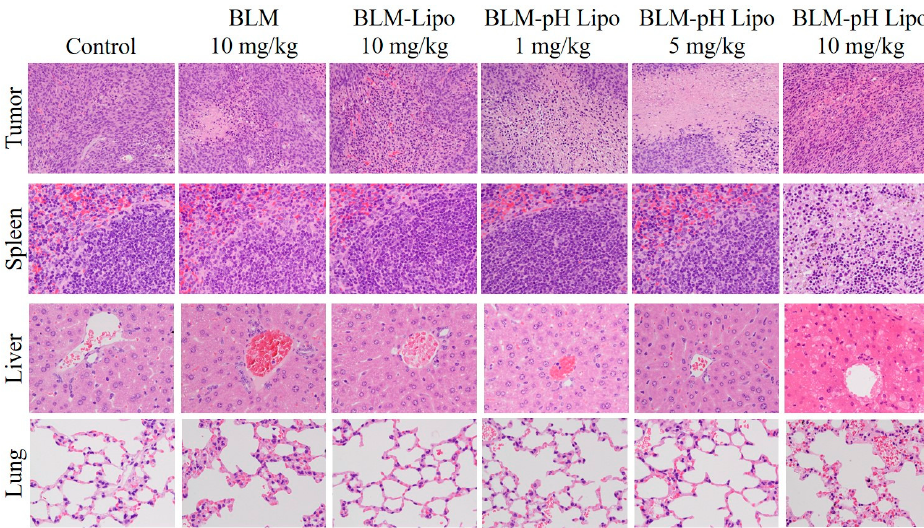
Figure 7. Evaluation of systemic toxicities by hematoxylin and eosin (H&E) staining showing histopathological changes in tumor, spleen, liver, and lung. In the cases of the control, BLM, BLM-Lipo (10 mg/kg), BLM-pHLipo (1 mg/kg) and BLM-pHLipo (5 mg/kg) groups, organs were isolated 12 days after treatment. In the case of BLM-pHLipo (10 mg/kg) groups, organs were isolated 4 days after treatment. Tumors (×20). Spleen, liver, and lung (×40).